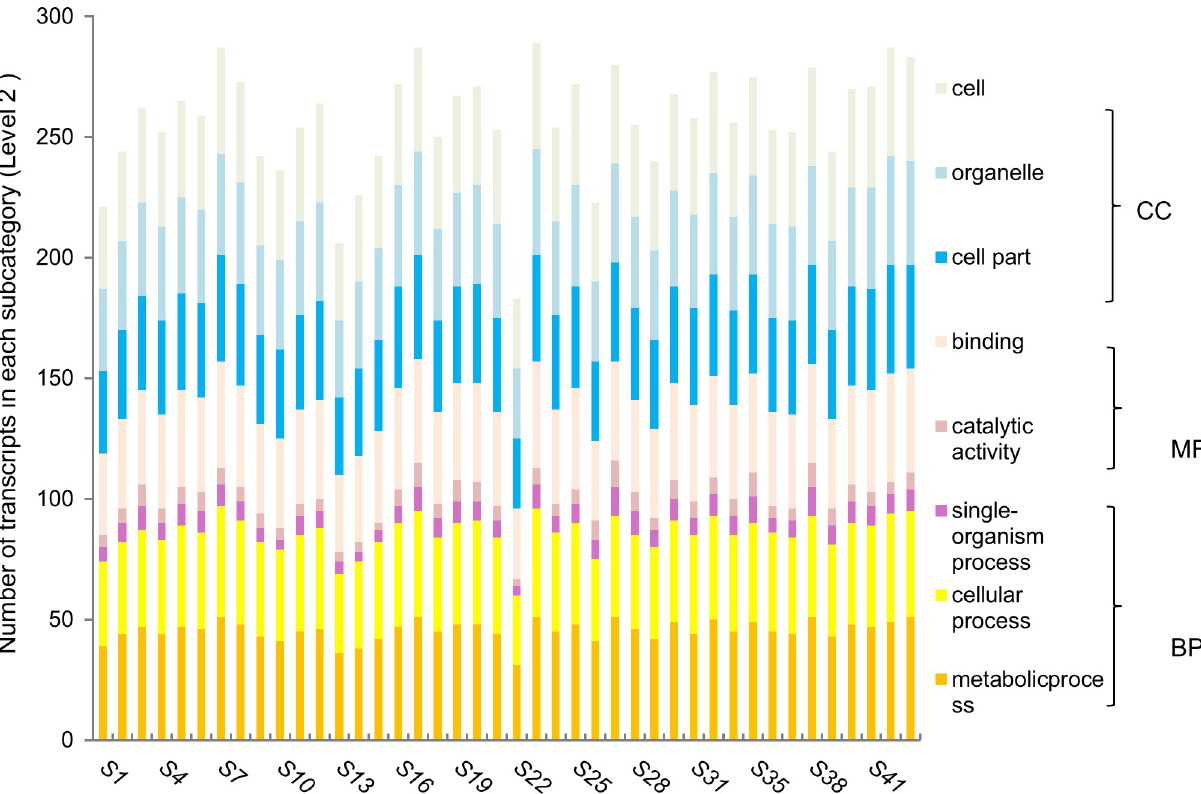
Fig 4. Variation of the functional categorization of the PgNAC transcripts among the four-year-old plant roots of 42 genotypes sampled from Jilin, China.